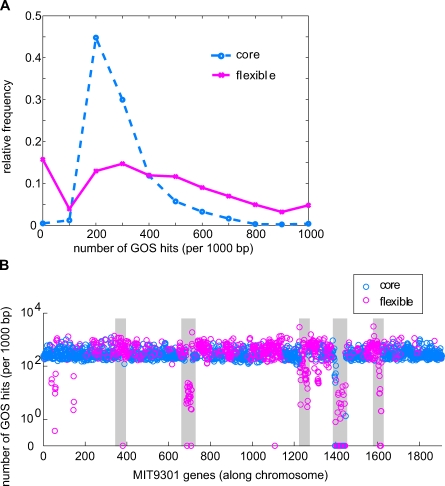

Prochlorococcus Core and Flexible Genes in the Global Ocean Survey (GOS) Dataset [64](A) Frequency distribution of GOS hits per gene, using genes in the Prochlorococcus MIT9301 genome as queries. Most core genes retrieve a similar number of GOS hits, as one would expect from single copy genes shared by all Prochlorococcus, resulting in a relatively tight frequency distribution. In contrast, flexible genes retrieve a broad range of GOS hits per gene, consistent with their scattered distribution among genomes.(B) The number of GOS hits per gene, again using MIT9301 genes as queries, plotted against position along the chromosome. Shaded regions represent genomic islands, after [60]. Flexible genes with low representation in the GOS dataset tend to be located in genomic islands. In both (A) and (B), the number of GOS hits per gene is normalized to gene length and plotted as hits per gene, per 1,000 bp.